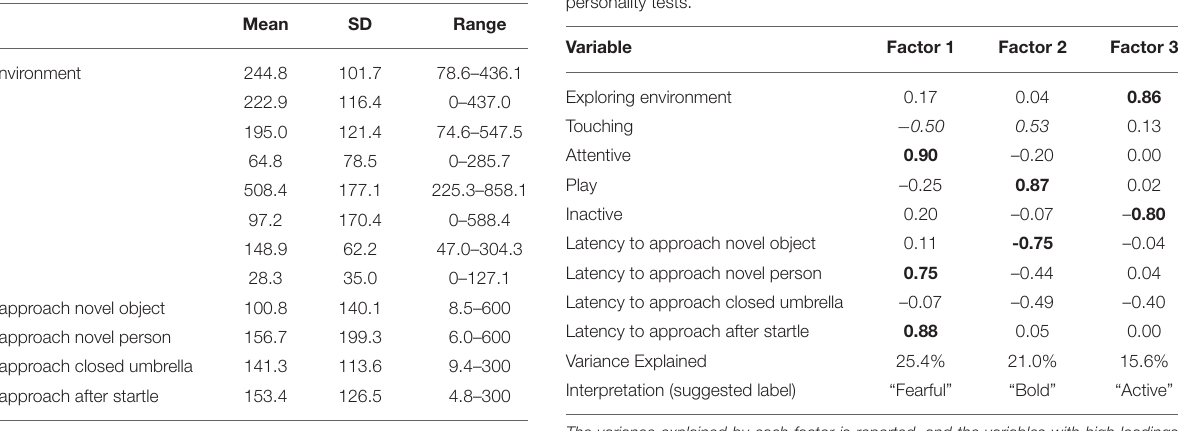
TABLE 3 | Coefficient loadings of each variable on the 3 factors extracted from the principal component analysis of behavioral responses in the traditional personality